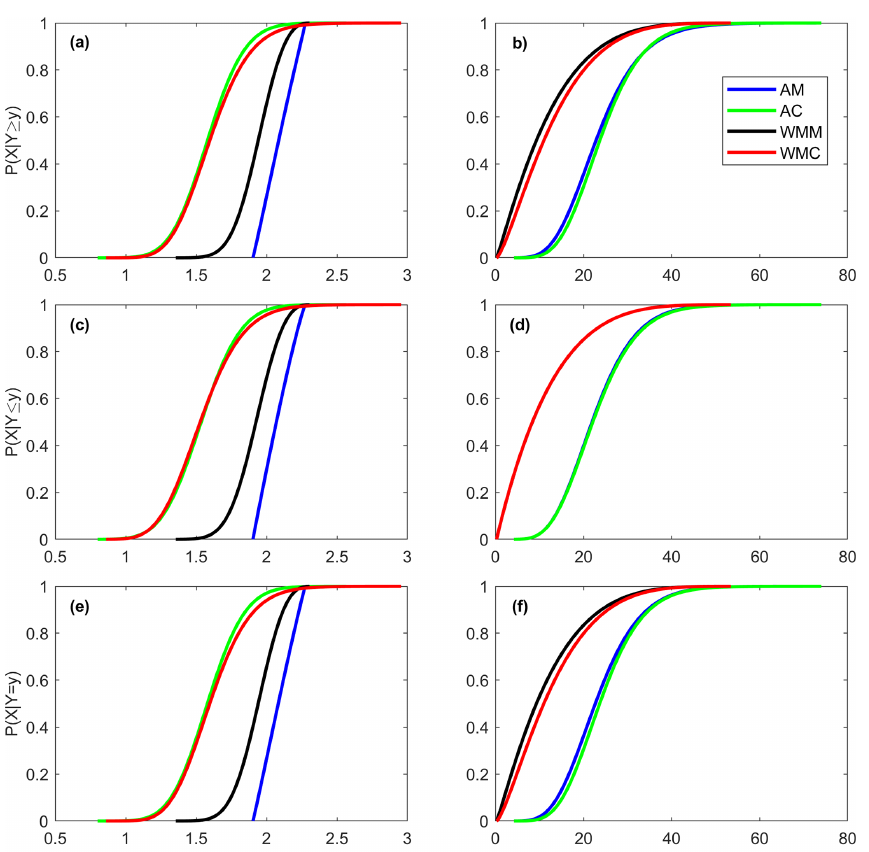
Figure 7. San Diego OWL (left column) and precipitation (right column) (a, b) C1, (c, d) C2, and (e, f) C3 CDFs for annual maximum (AM; blue), annual coinciding (AC; green), wet-season monthly maximum (WMM; black), and wet-season monthly coinciding (WMC; red) samplings using the BB1 copula. OWL and precipitation conditionals are conditioned on the occurrence of a 25-year precipitation or OWL event.